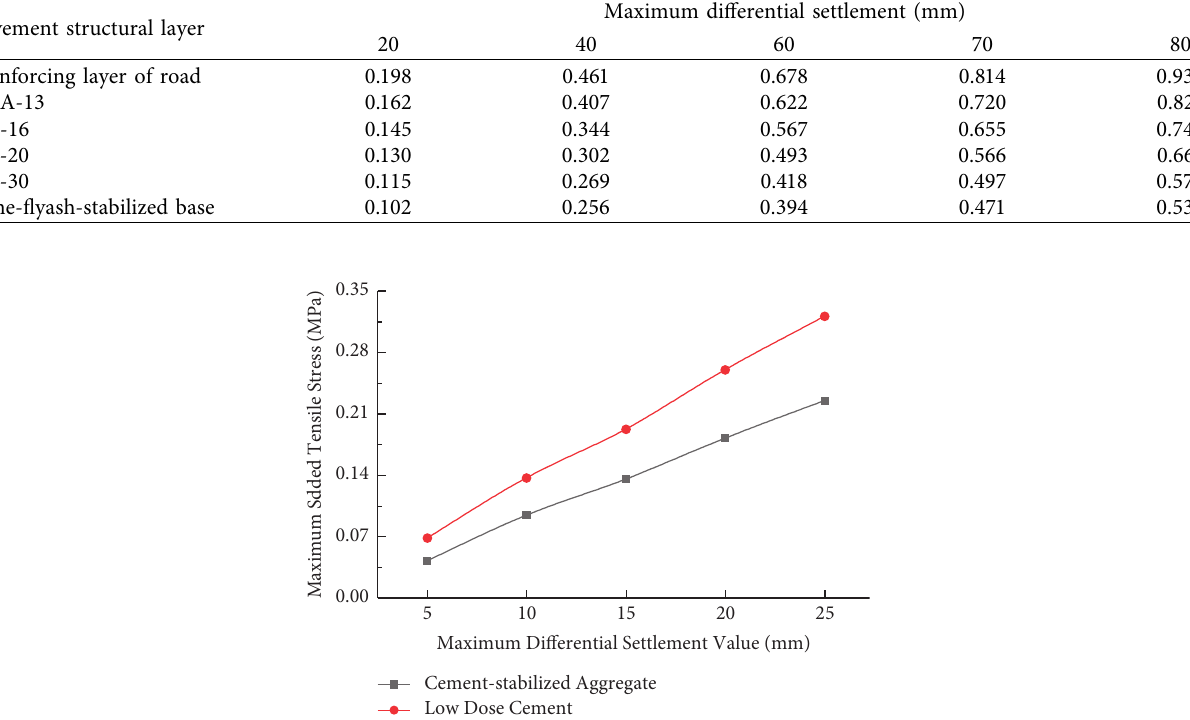
Figure 21: Maximum tensile stress of the new pavement structure layer under different differential settlements. Table 7: Calculation results of maximum tensile stress of the new pavement structure layer under different differential settlements (MPa). Pavement structural